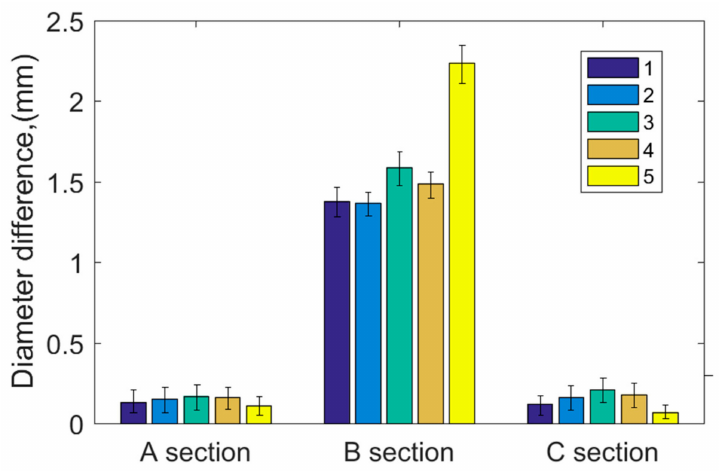
Figure 11. Diameter increase before and after